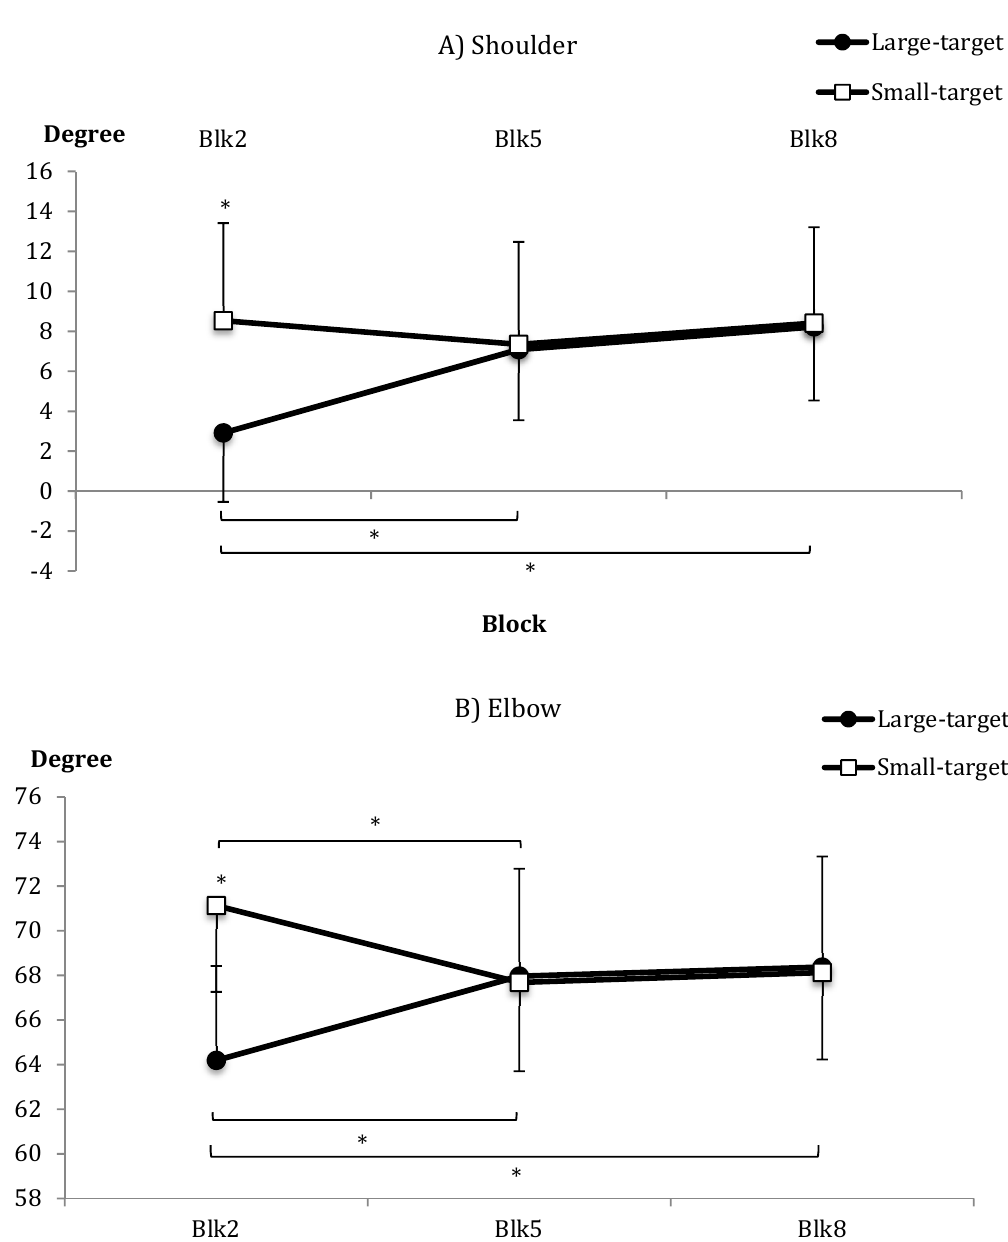
Figure 6. Mean ( A ) shoulder and ( B ) elbow joint amplitudes (and SE bars) as a function of group and block (blocks 2, 5, and 8). * p < 0.05